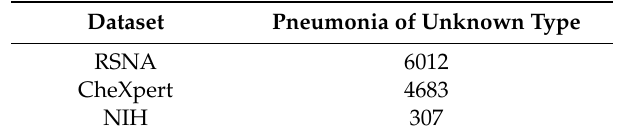
Table 2. Characteristics of datasets used for weak-label classification.